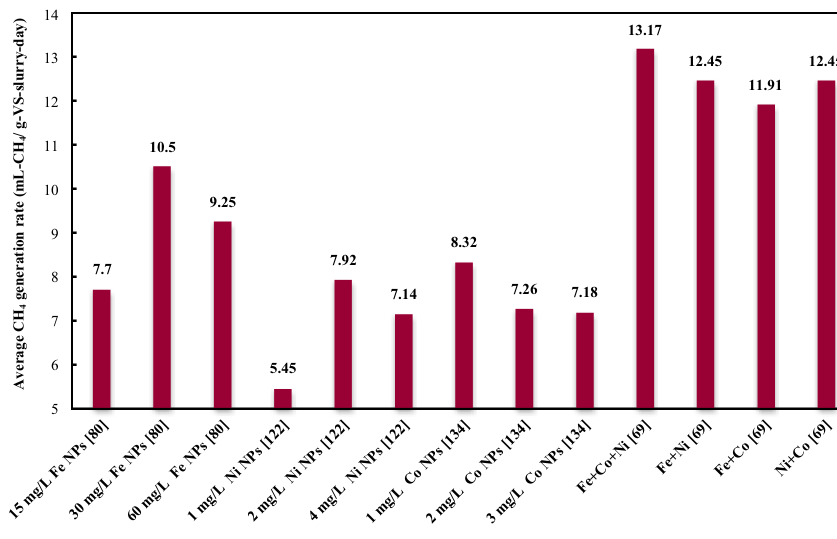
Fig. 1 Effect of different nano- particle additives on average methane generation rate